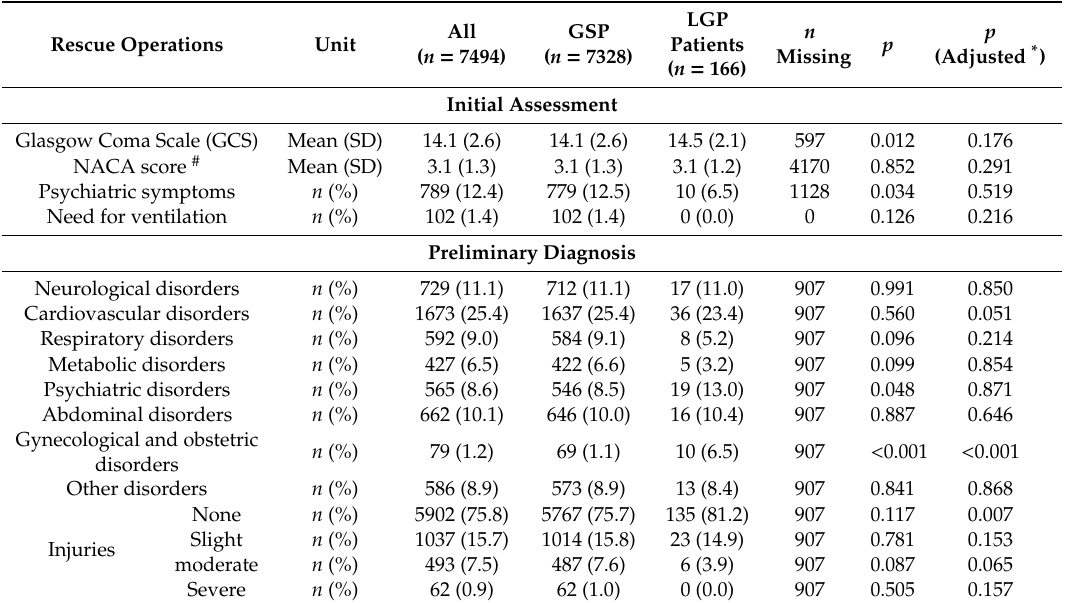
Table 3. Medical characteristics of